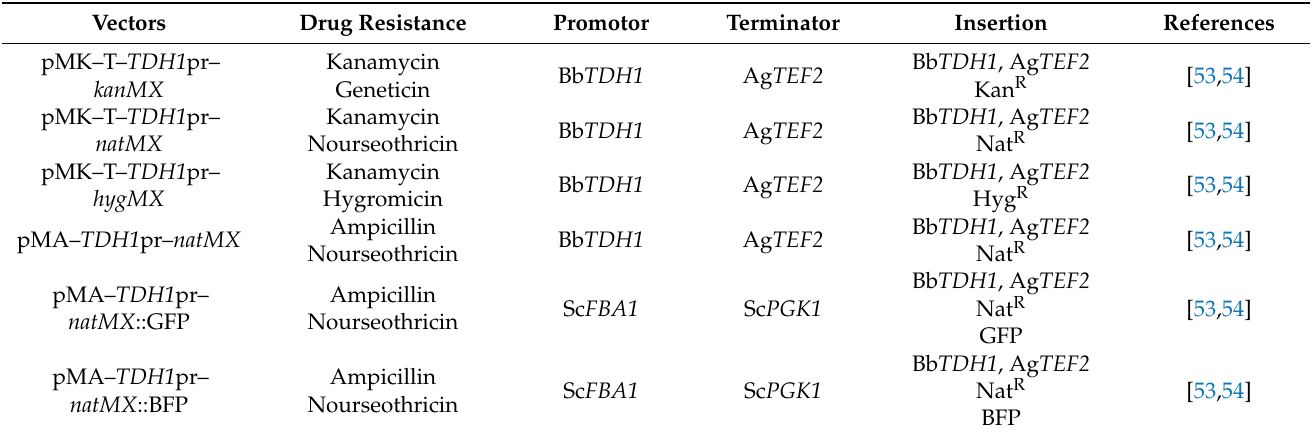
Table 4. Available molecular cassettes for B. bruxellensis